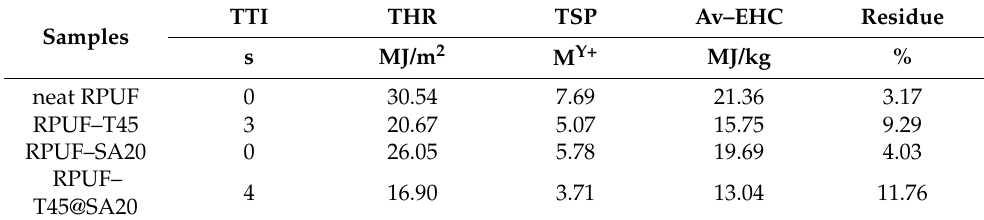
Table 6. Characteristic CC data of neat RPUF, RPUF–T45, RPUF–SA20, and RPUF–T45@SA20.